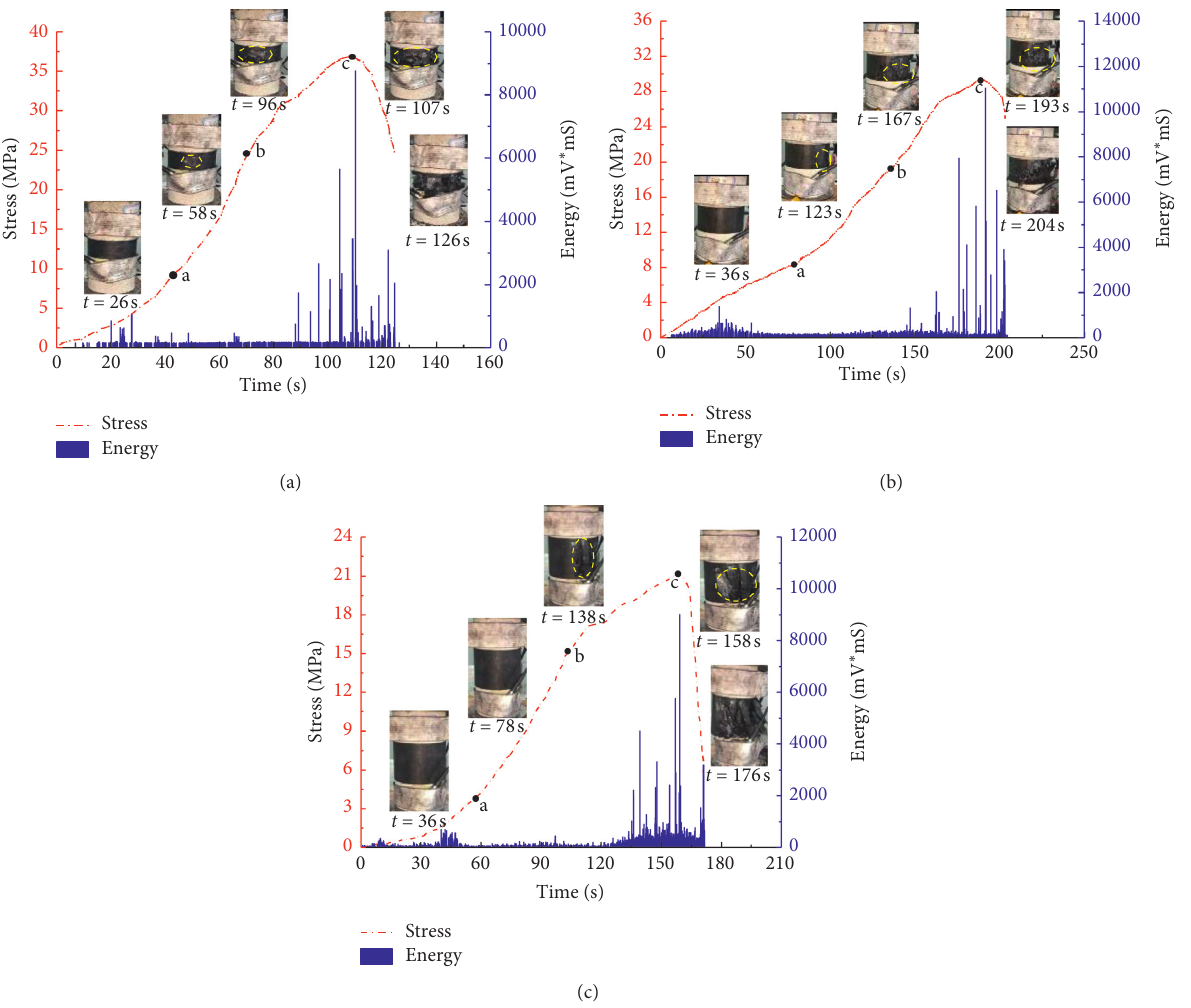
Figure 8: Evolution law of stress-strain and acoustic emission of a typical combined sample: (a) C-1 sample; (b) D-3 sample; (c) E-1